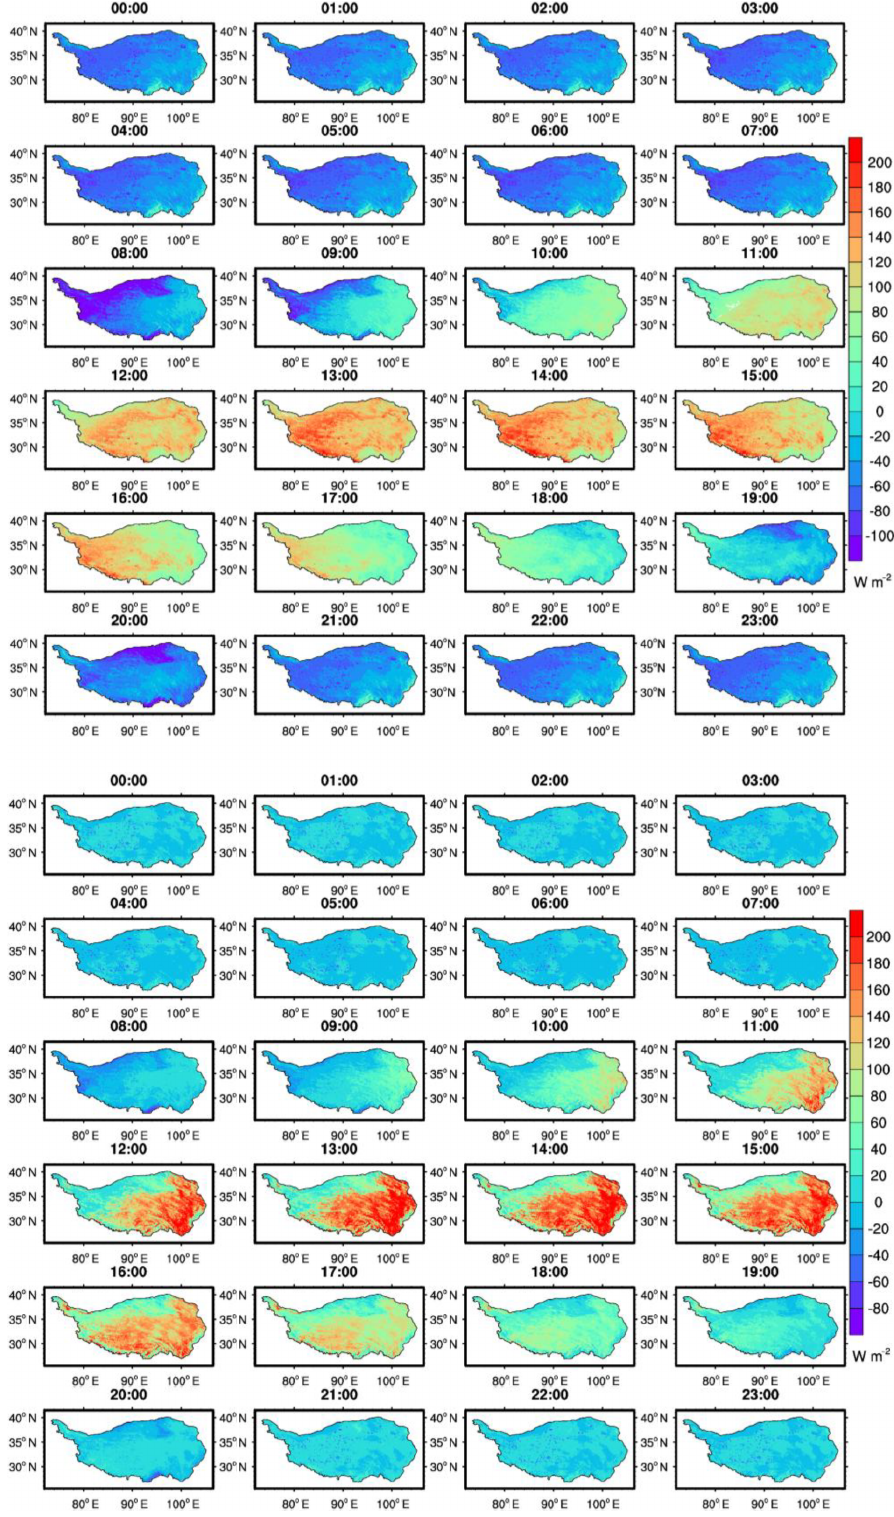
Figure 6. Annual mean spatial distribution and diurnal cycle of sensible heat flux (top panels) and latent heat flux (bottom panels) in 2008 over the